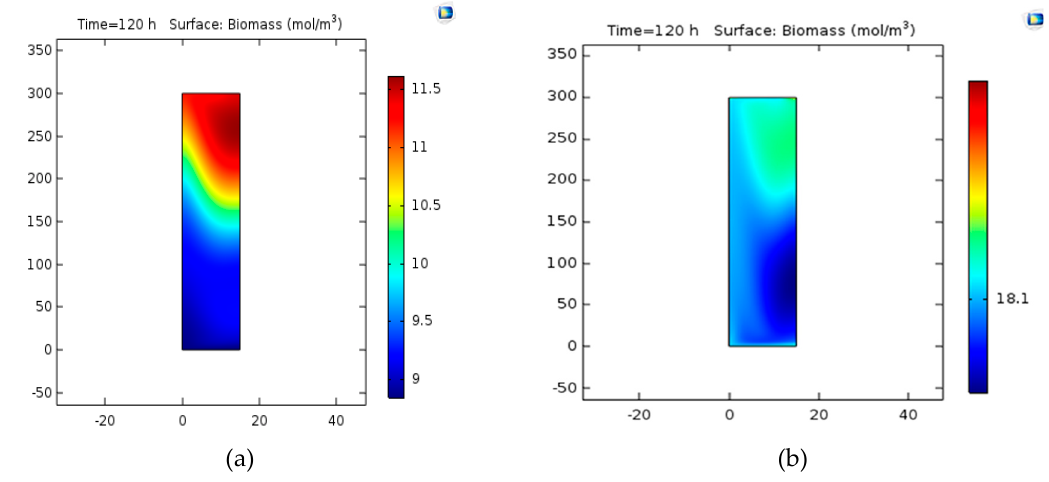
Figure 9. ( a ) Biomass concentration with a bubble diameter of 3.5 mm. ( b ) Biomass concentration with a bubble diameter of 1.5 mm.